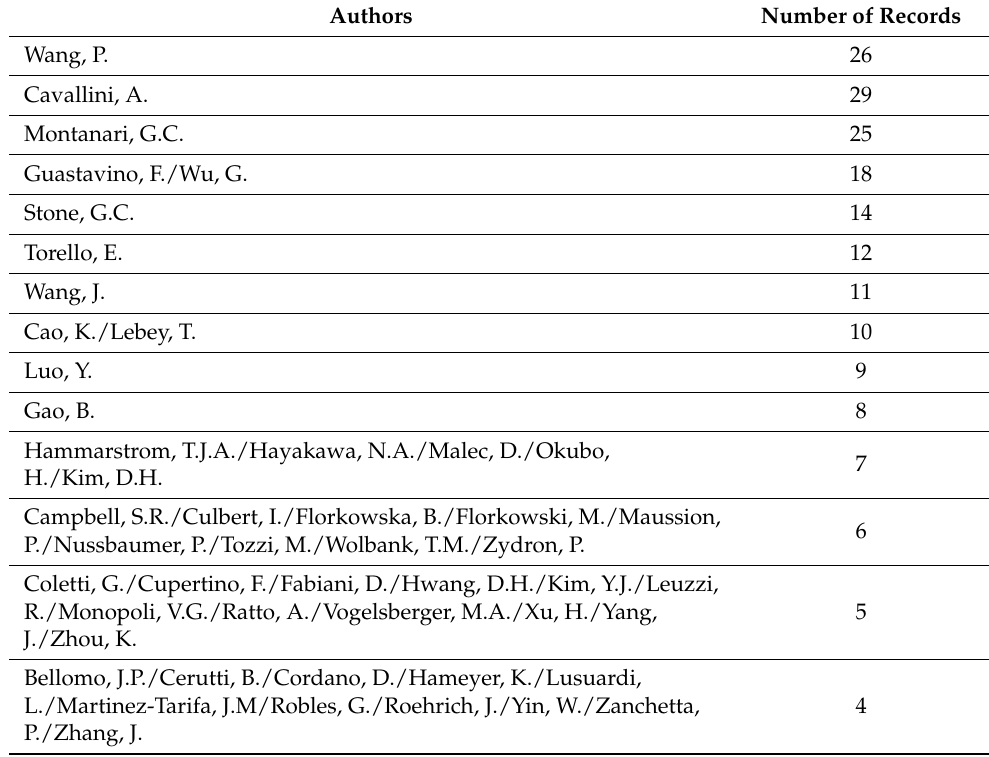
Table 5. Number of articles in relation to their